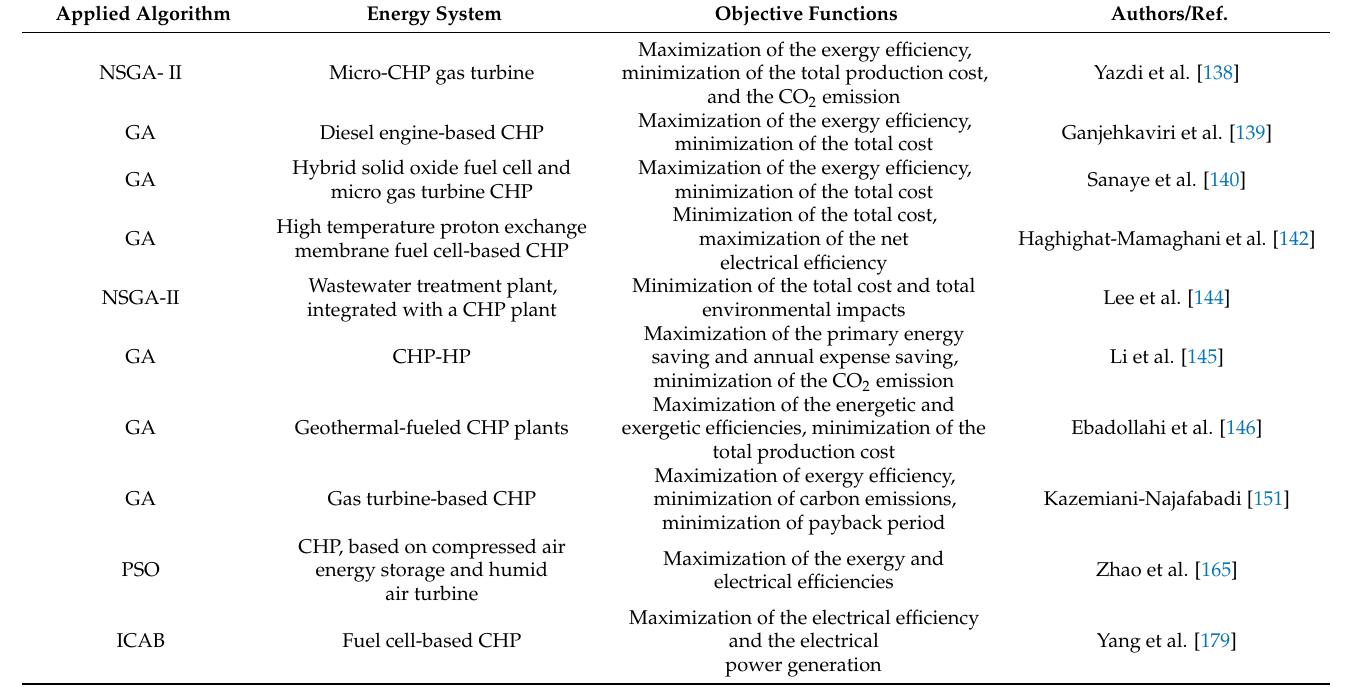
Table 8. Multi-objective designing issues of CHP energy systems.